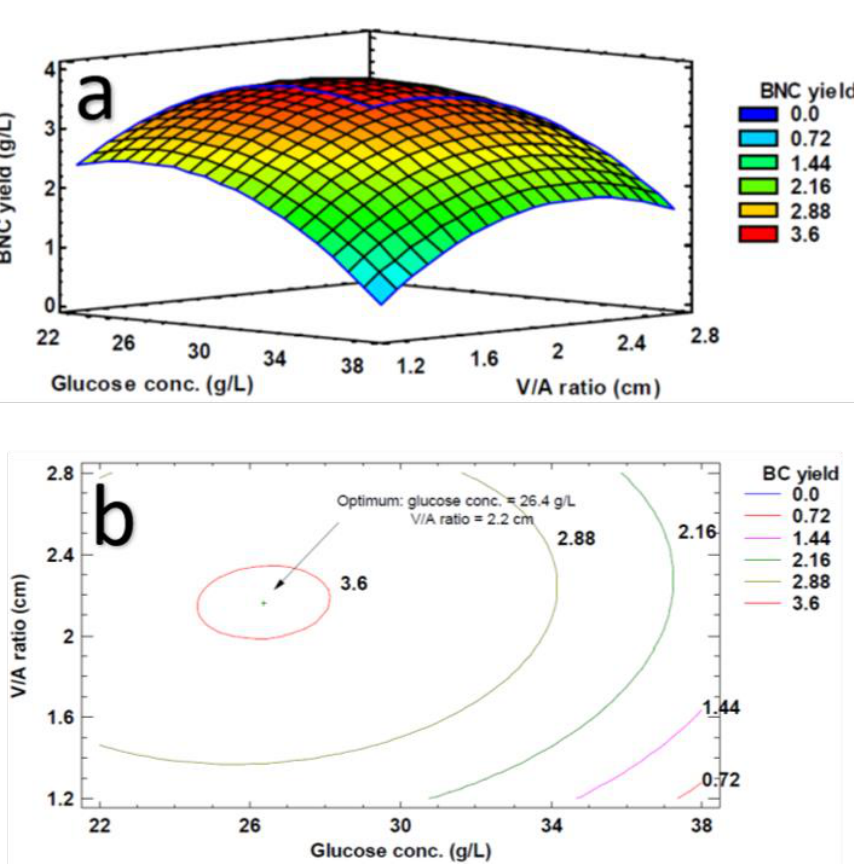
Figure 2. ( a ) Response surface methodology of the BNC yield as a function of the glucose concentration and V/A ratio. ( b ) Contour diagram.